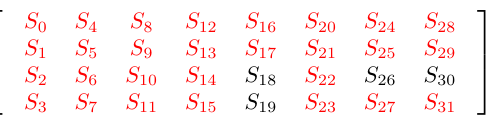
Figure 14: The active nibbles after bit permutation in the second round, marked in red.